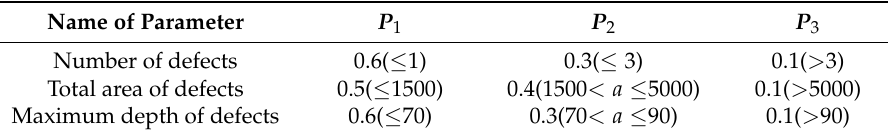
Table 3. Surface quality indexes of the standard particleboard.